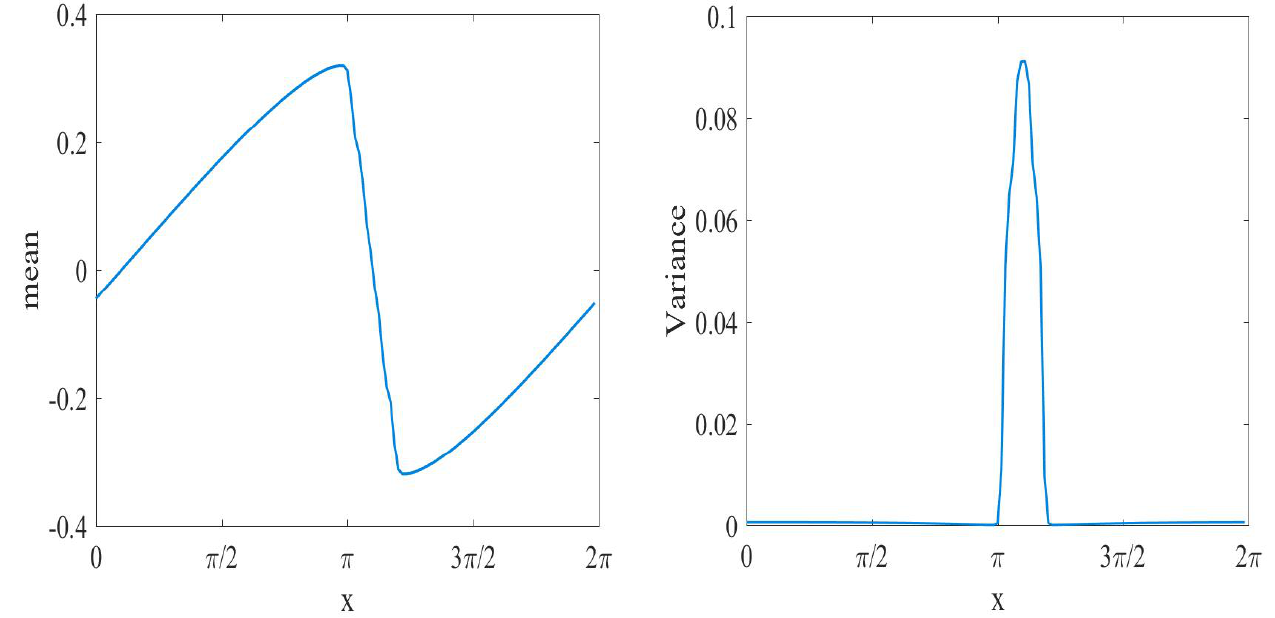
Figure 14. The mean solution ( left ) and its variance ( right ) for the inviscid Burgers’ equation switching at t s =1 with modes number N =4